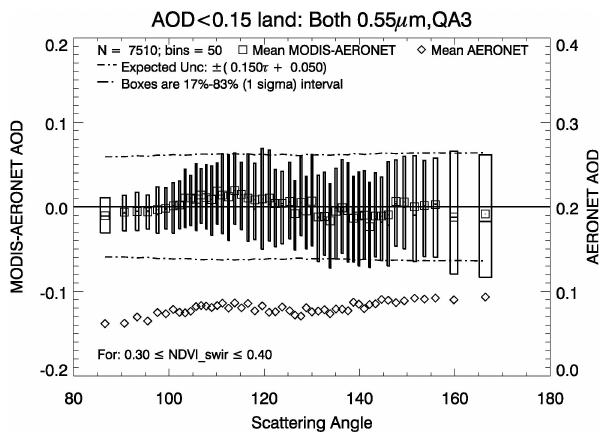
Fig. 14. Differences between MODIS and AERONET -reported AOD at 0.55µm (MODIS-AERONET) vs. MODIS-observed scat- tering angle, for QAC=3, for “light”( τ < 0 . 15) aerosol load- ing cases only, for a small subset of the NDVI swir range (0.30 ≤ NDVI swir ≤ 0.40). The explanation of symbols is given in Fig. 6.